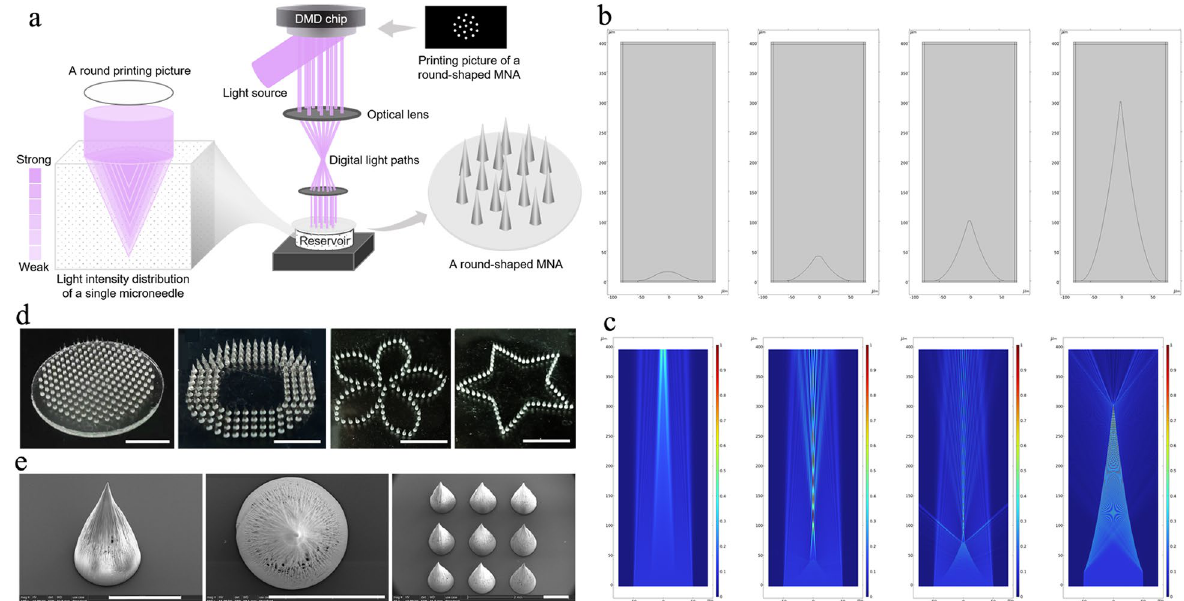
Fig. 1 Customization of MNA by SOPL. a Schematic diagram of the principle for customization of the MNA by SOPL. b 2D geometric models of a microneedle at heights of 10, 40, 100 and 300 μm constructed in COMSOL. c The light intensity distribution of the microneedle at heights of 10, 40, 100 and 300 μm simulated by COMSOL. d Photographs of round-, annular-, petaloid-, and pentagonal star-shaped MNAs. (Scale bars: 500 mm). e SEM images of the microneedles and the MNAs. (Scale bars: 500